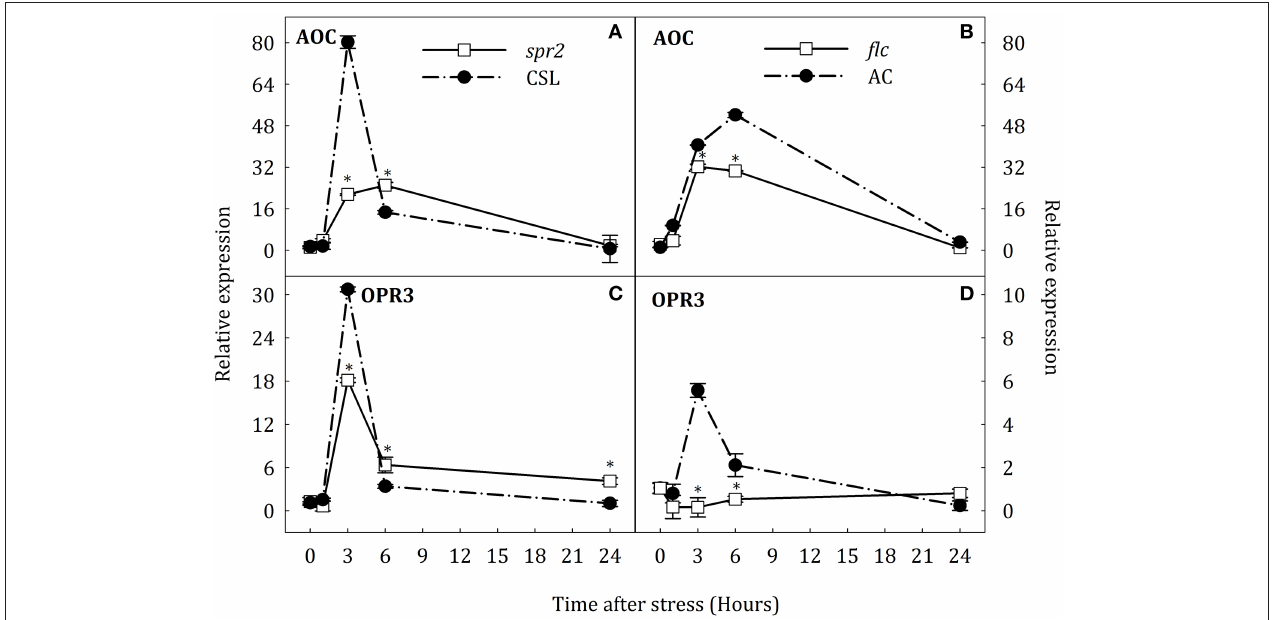
FIGURE 5 | Relative expression of AOC (A,B) and OPR3 (C,D) in roots of Solanum lycopersicum [WT (CSL and AC, black circles) and mutants ( spr2 and flc , white square)] under control ( t = 0 ) and water-stress conditions. Data are mean values ± standard deviation of three independent determinations. Asterisks denote statistical difference with respect to WT at p ≤ 0.05